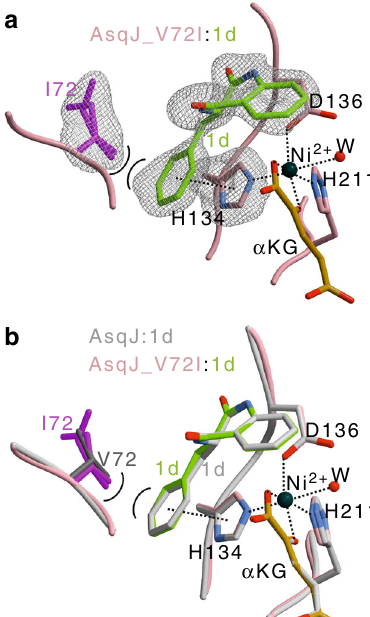
Fig. 5 Crystal structure of the AsqJ_V72I mutant. a ) Close-up of the active site in complex with 1d (shown in green). The amino acids engaged in ligand binding are depicted as sticks and labeled by the one letter code, α - ketoglutarate ( α KG) shown in orange, and Ni II is shown as a black sphere. The electron density depicts a 2 F o – F c map with I72, H134, and 1d omitted for phasing. I72 contains two alternative conformations with an occupancy of ~50% (PDB ID: 5OA8). An extra lobe of electron density around the phenyl ring of 1d indicates increased mobility of the phenyl ring. b Structure of the active site superposition of AsqJ_V72I: 1d with the wt AsqJ: 1d (shown in gray; PDB ID: 5DAX). π -stacking and coordination of the metal atom are indicated by black-dotted lines. Note that the surrogate 1d adopts identical positions in both crystal structures, while there are only marginal shifts in the distances of I72 coordinating the aromatic moiety of the